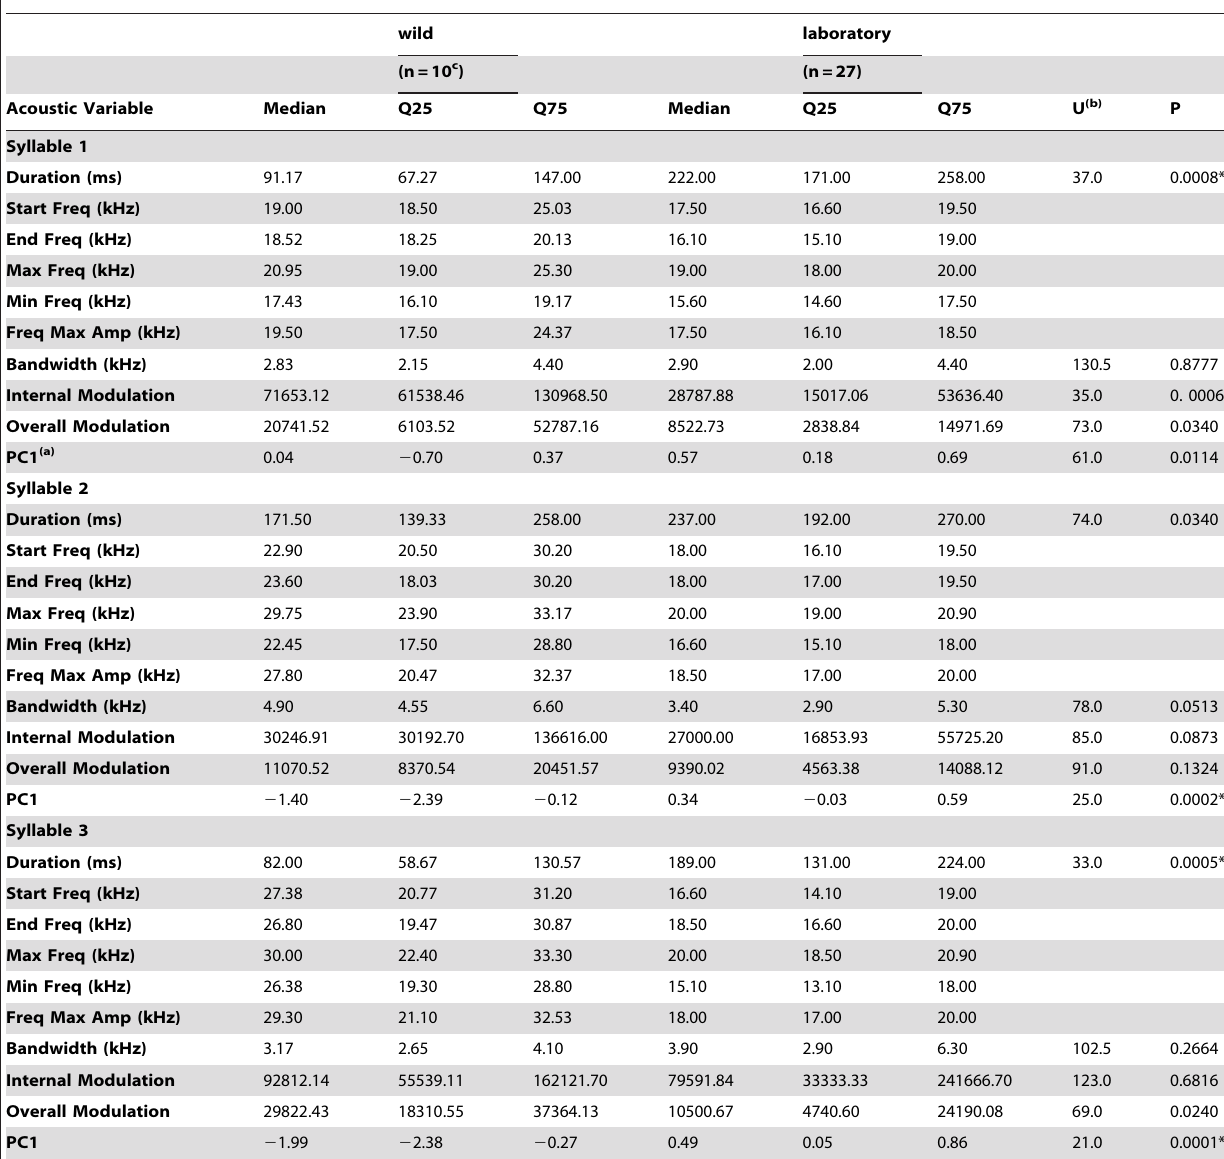
Table 3. Comparison between laboratory- and wild-recorded 3SVs.